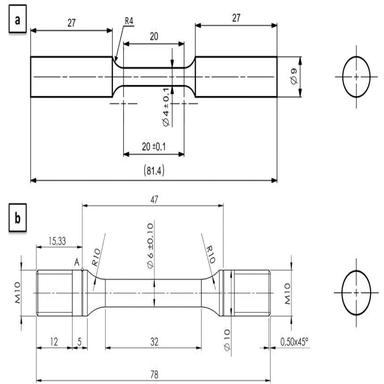
(a) Machined specimens geometry tested using MTS Minibionix servo-hydraulic machine; (b) as-built specimens geometry tested using Zwick Roell Z250 SE machine for RT test and Zwick Roell Z050 TH servo-hydraulic testing machine for HT test in TEC-Eurolab.